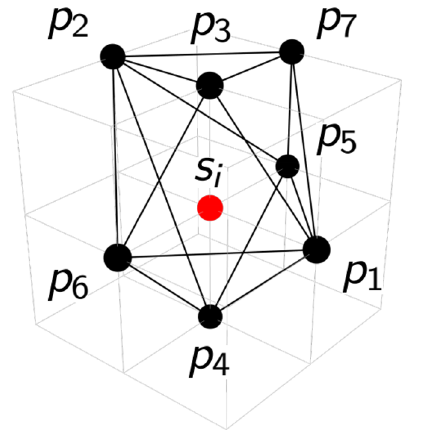
Figure 37 . Toric diagram for Model